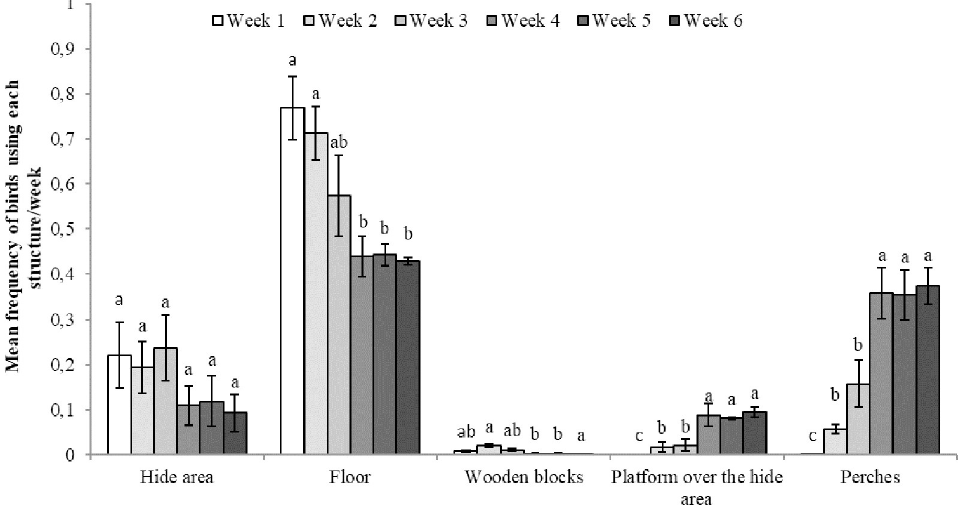
Fig 10. Use of different areas in the complex environment treatment. Mean (+ SE) frequency of birds using the different areas of the pen by week in the CENV treatment; (a-d) letters indicate differences in the use of the structures (P < 0.05) across